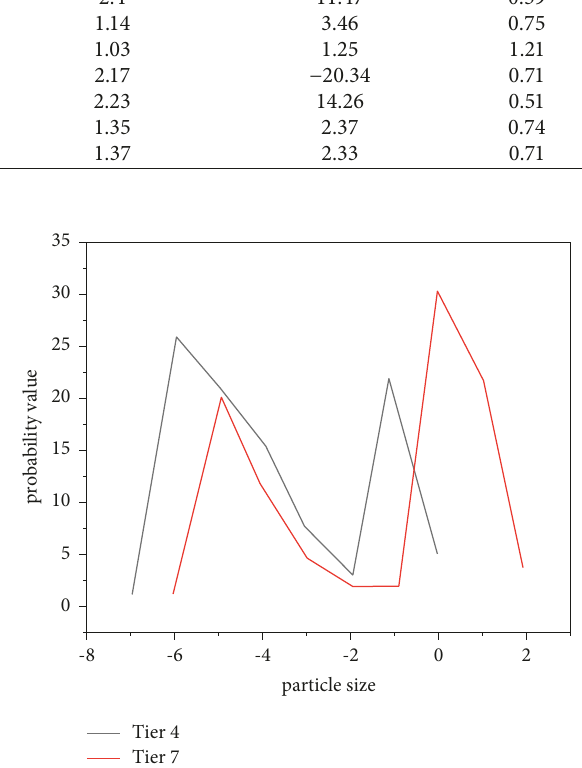
Figure 1: Grain size frequency curve of sediments in layers 4 and